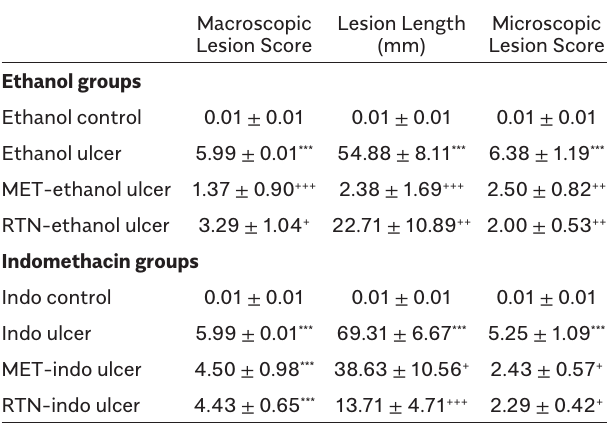
Table 1. Macroscopic Lesion Score, Lesion Length, and Microscopic Score of the Stomach in Experimental Groups